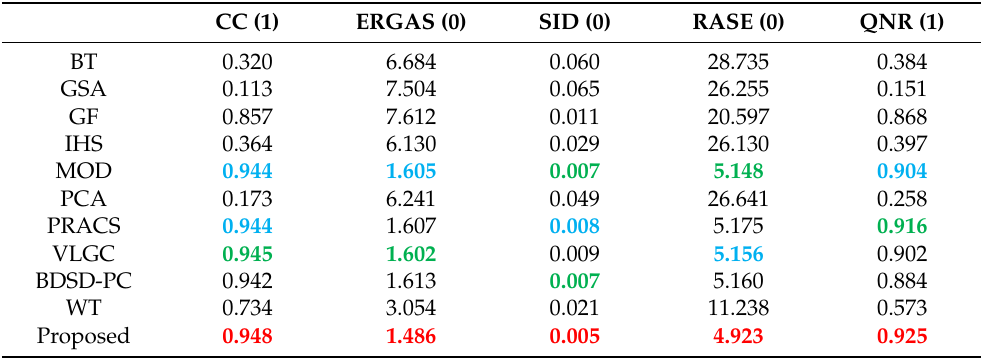
Table 2. Objective evaluation of the experimental results on the first image